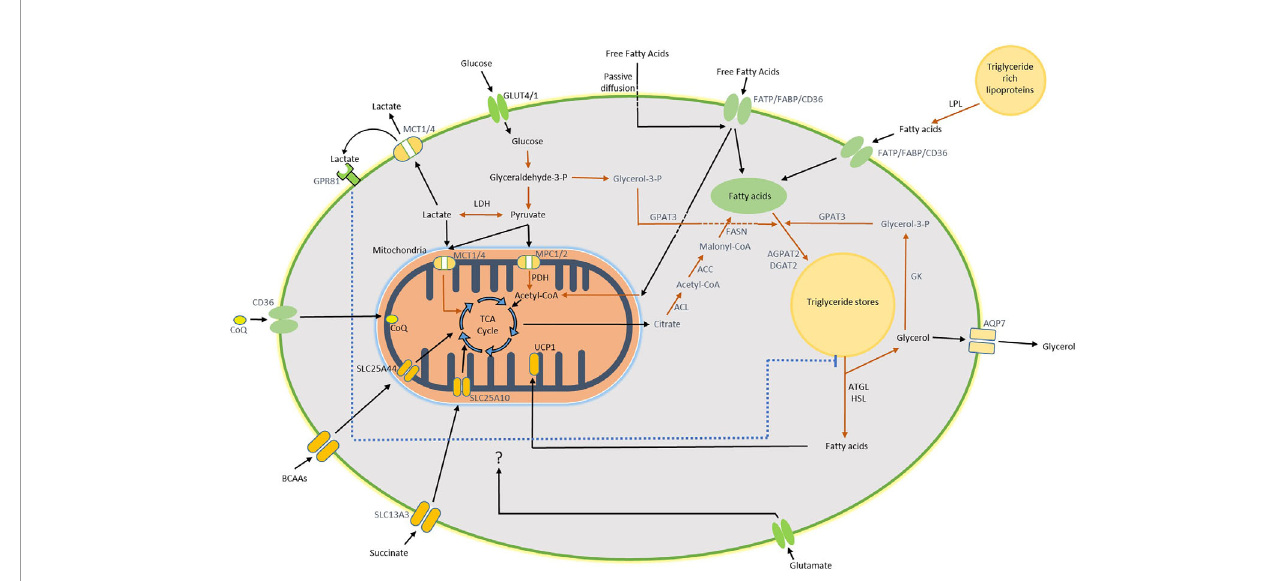
FIGURE 1 | Diagram of substrate utilization and suspected pathways in BAT. Glucose enters the brown adipocyte via GLUT4 and GLUT1 where it undergoes glycolysis to form pyruvate. Pyruvate is converted to lactate and exported from the cell by the monocarboxylate (MCT) transporters, this pathway accounts for the majority of glucose uptake by human BAT during both warm and cold exposure. Following export, lactate may activate GPR81 which inhibits lipolysis. Alternatively, pyruvate can enter the mitochondria and be incorporated into the TCA cycle following conversion to acetyl-CoA. Citrate, one of the TCA cycle intermediates, may also be converted to acetyl-CoA in the cytosol as the fi rst step of de novo lipogenesis (DNL). A proportion of glucose may be converted to glycerol-3-phosphate (Glycerol-3-P), generated from glyceraldehyde-3-phosphate during glycolysis, to form the backbone for replenishment of intracellular triglycerides (TRGs). Free fatty acids (FFAs) hydrolysed from local TRGs are the primary energy substrate used for uncoupled respiration during thermogenesis, which is mediated by mitochondrial UCP1. Glycerol released by this process can either be exported or recycled through conversion to Glycerol-3-P by glycerol kinase (GK) for subsequent TRG synthesis. In addition to DNL, uptake of circulating FFAs either directly or following lipoprotein lipase (LPL)-mediated hydrolysis of triglyceride rich lipoproteins (TRLs) occurs via the fatty acid transporters or potentially by passive diffusion. BAT utilizes other circulating substrates during thermogenesis such as BCAAs, succinate and glutamate which are all likely incorporated into the TCA cycle. Arrows in black indicate substrate transport/movement. Arrows in red represent enzymatic conversion. Wording in black indicate pathway con fi rmed both in human and rodent BAT. Wording in blue indicate pathways con fi rmed in rodent BAT. Some reactions have been simpli fi ed/omitted for brevity. ACC, acetyl-CoA carboxylase; ACL, ATP citrate lyase; AGPAT2, 1-acyl-sn-glycerol-3-phosphate acyltransferase beta; AQP7, aquaporin-7; ATGL, adipose triglyceride lipase; CD36, fatty acid translocase; CoQ, coenzyme Q; DGAT2, diacylglycerol acyltransferase 2; FABP, fatty acid binding protein; FASN, fatty acid synthase; FATP, fatty acid transport protein; GPAT3, glycerol-3-phosphate acyltransferase 3; GPR81, G-protein coupled receptor 81; HSL, hormone sensitive lipase; LDH, lactate dehydrogenase; MPC1/2, mitochondrial pyruvate carrier 1 and 2; PDH, pyruvate dehydrogenase; SLC13A3, solute